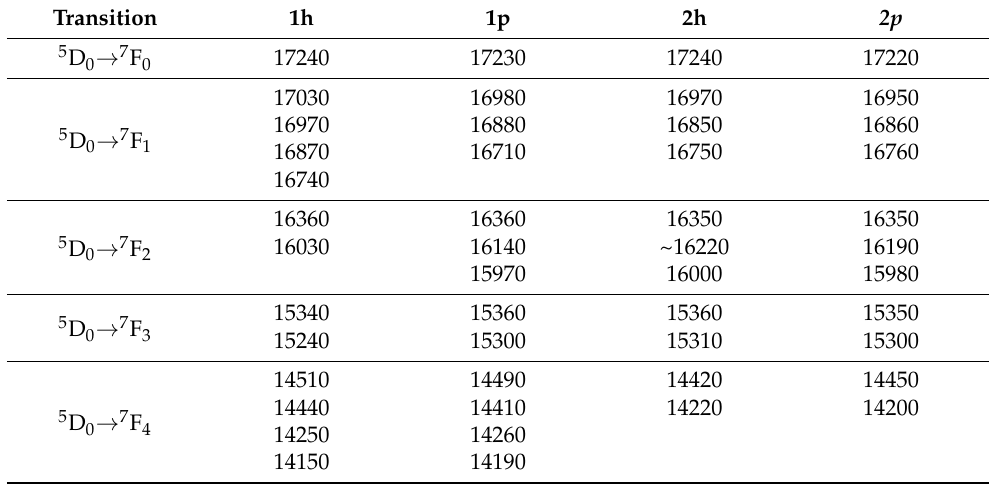
Table 2. The energies (in cm − 1 ) of the Stark components for the f * -f transitions of the Eu 3+ ion in the complexes studied.